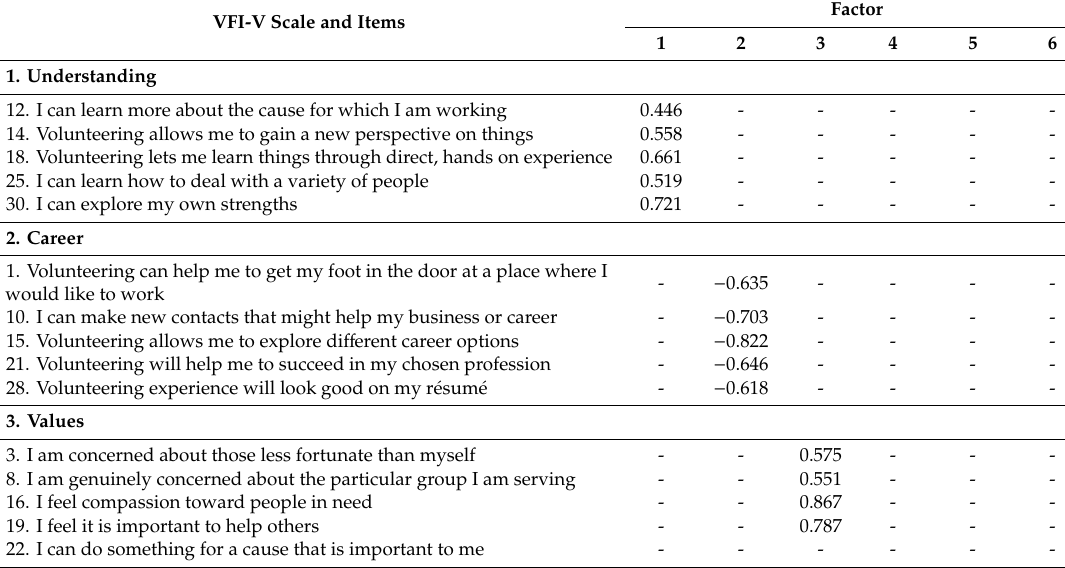
Table 3. Exploratory Factor Analysis (EFA) results: Pattern matrix for the Dutch VFI (translated version of the original VFI) (Principal-Axis Factor Analysis, Oblique Rotation, Six factors